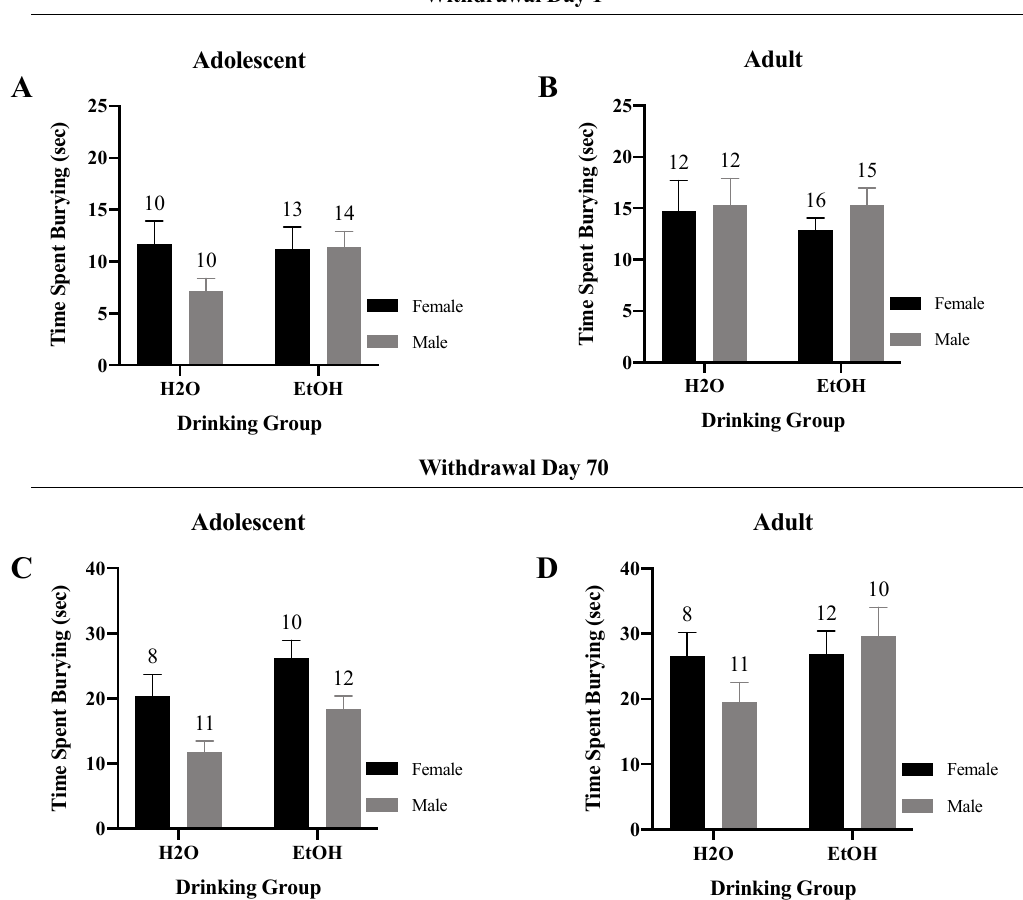
Figure 7. Summary of the results for the Sex × Drinking ANOVA observed for the total time spent burying marbles in the marble-burying test. ( A ) Depiction of the results for the adolescent-onset mice at 1-day withdrawal. ( B ) Depiction of the results observed for the adult-onset mice at 1-day withdrawal. ( C ) Depiction of the results for the adolescent-onset mice at 70-days withdrawal. ( D ) Depiction of the results for the adult-onset mice at 70-days withdrawal. The data represent the means ± SEMs for the numbers of mice indicated in each panel.